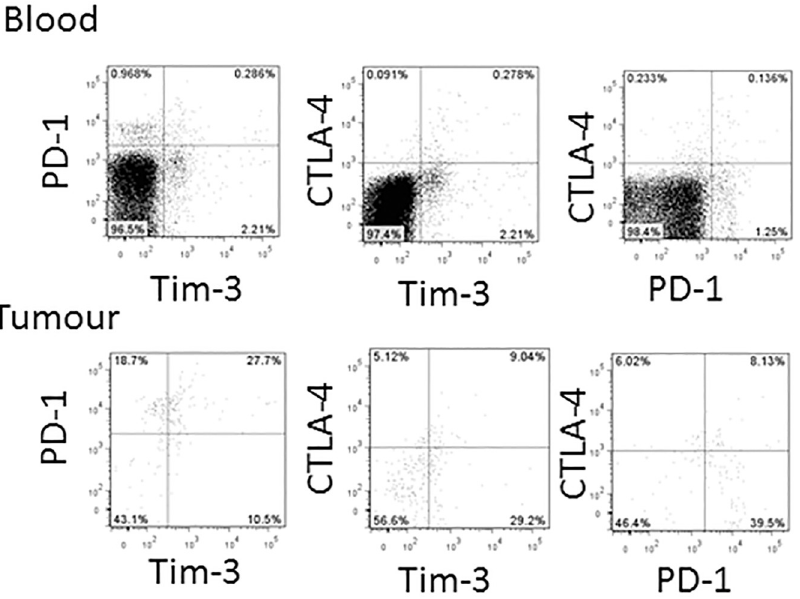
Fig 5. Limited co-expression of PD-1, Tim-3 and CTLA-4 in the blood and tumour of a patient with expression of all three receptors. Gated CD8 T cell populations(live, CD45 + , CD3 + , CD8 + cells) from the blood (upper plots) and matching tumour sample (lower plots) were analysedfor co-expression of PD-1, Tim- 3 and CTLA-4 using flow